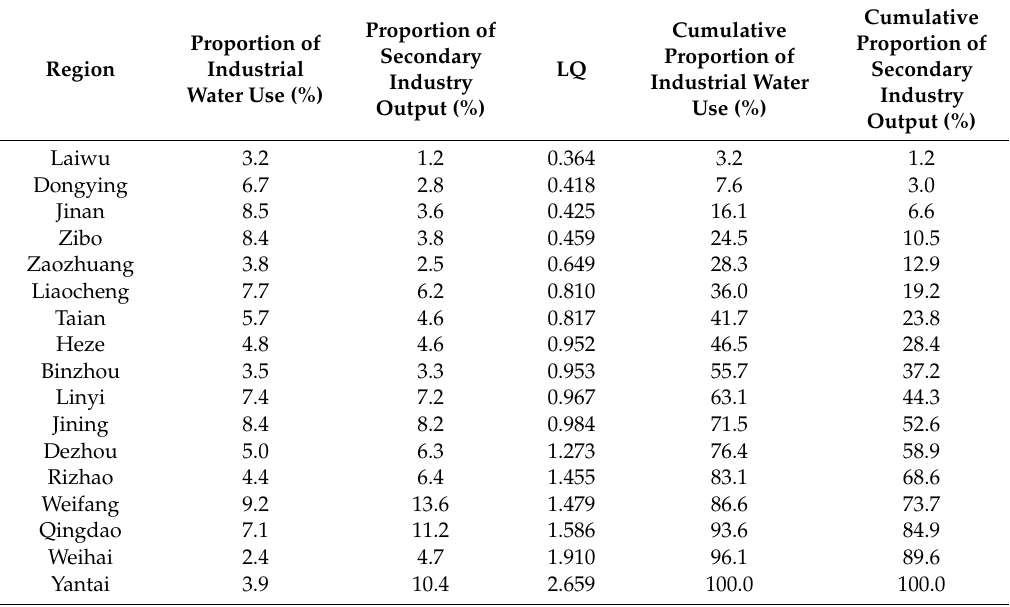
Proportion of Secondary Industry Output (%)